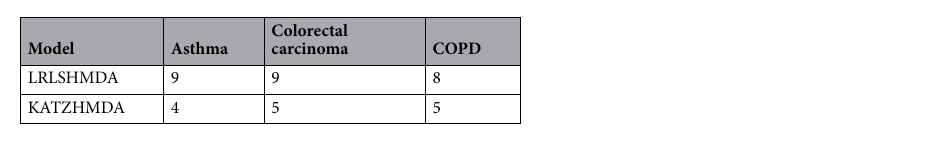
Table 4. Performance comparison between LRLSHMDA and KATZHMDA in the case studies of the confirmation of the top-10 prediction list for three human complex